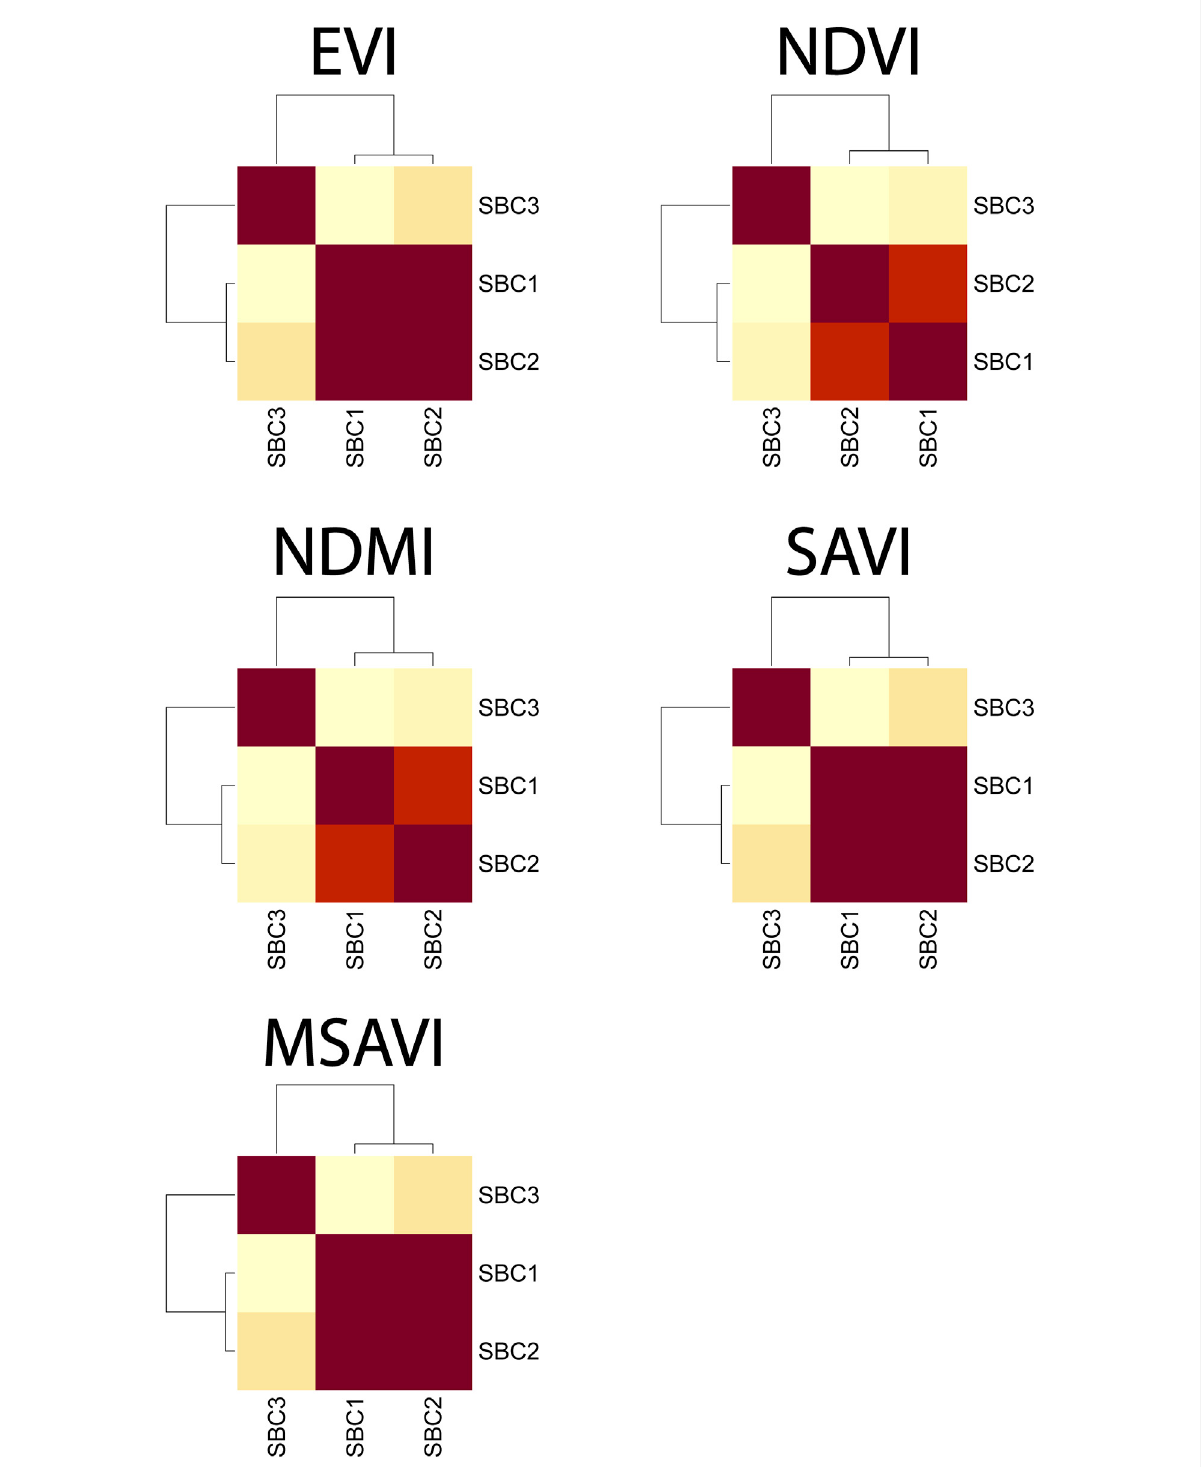
FIGURE 3 Clusteranalysisofthethreesub-catchments(SBC1,SBC2,andSBC3)fortheenhancedvegetationindex(EVI),normalizeddifferencevegetation index (NDVI), normalized difference moisture index (NDMI), soil-adjusted vegetation index (SAVI), and modi fi ed soil-adjusted vegetation index (MSAVI) Landsat 8-OLI